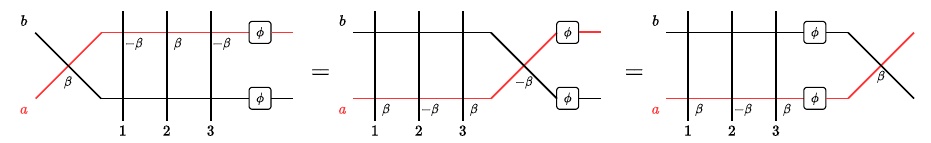
Figure 8: Graphical proof of Eq. (9.18) for an even number N of sites.